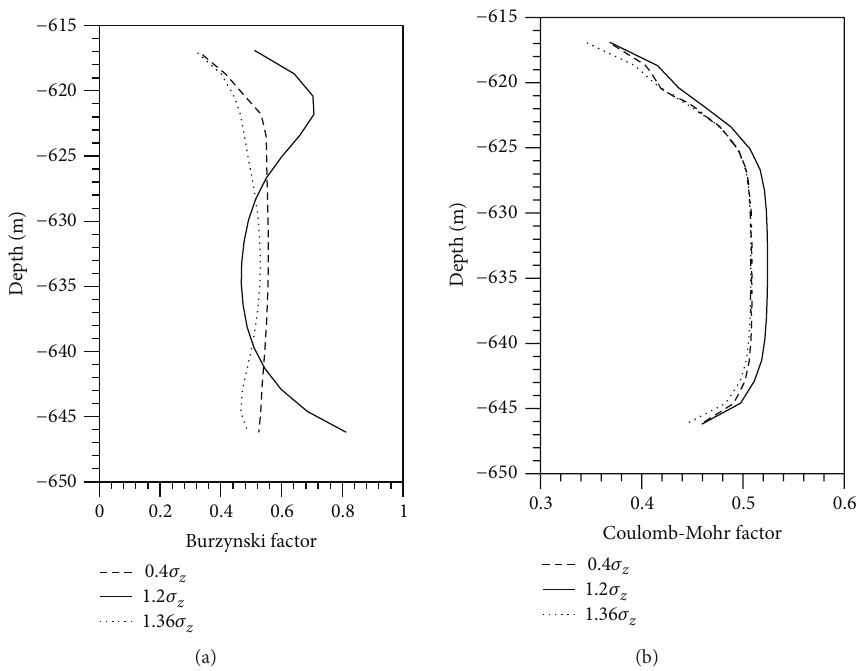
Figure 11: Failure factor according to Burzynski criterion (a) and to Coulomb-Mohr criterion (b) along the chamber wall for the detector chamber in anhydrite